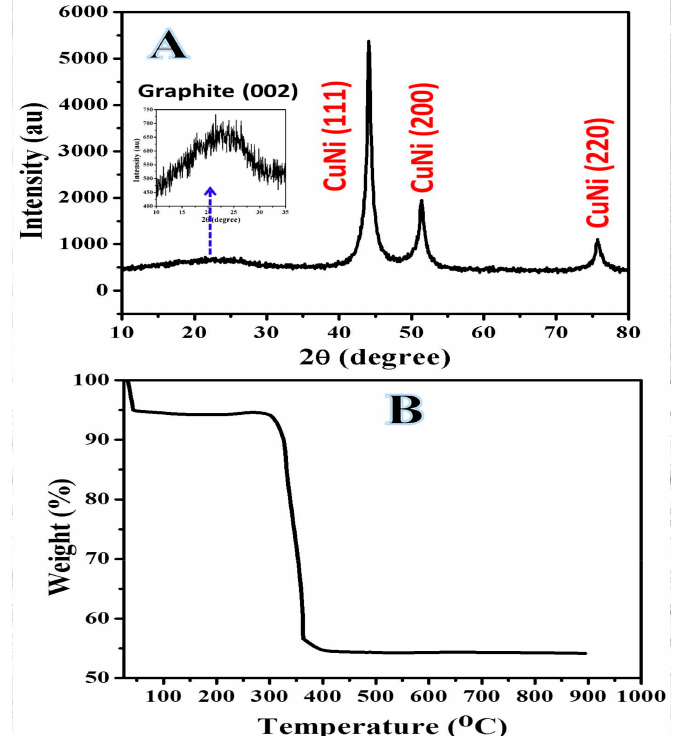
Figure 3. ( A ) XRD patterns of the calcined CuAC / NiAC / PVA mat NFs after sintering at 800 ◦ C for 5 h